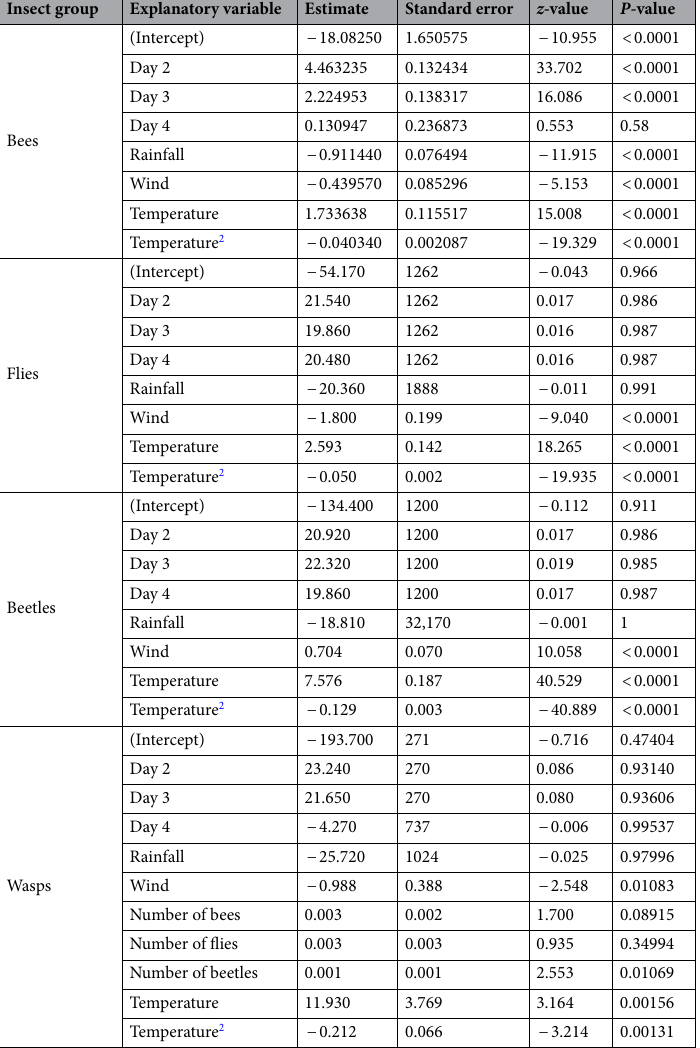
Table 1. Results of GLMM analysis examining the effects of weather factors and day of flowering on the number of photos featuring bees, flies, beetles and wasps visiting lotus flowers. The number of photos of each insect group per hour was assumed to follow a Poisson distribution. As weather factors, rainfall, strong wind, air temperature (°C), and the square of air temperature were analysed. For the analysis of wasps, the number of times each group of prey insects (bees, flies and beetles) were photographed was added to the explanatory variables.